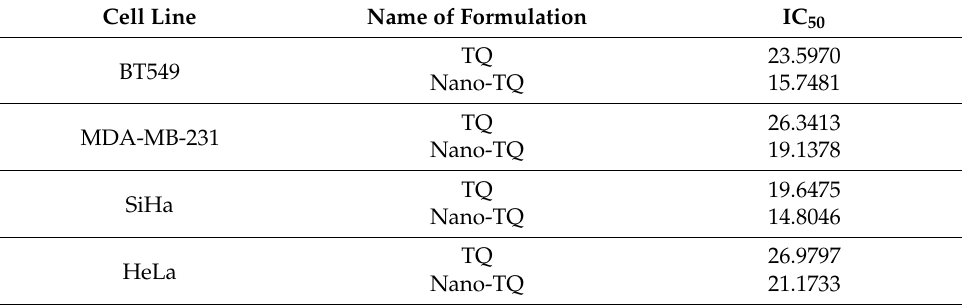
Figure 4. Effect of liposomal preparation of thymoquinone’s cytotoxic effect on cancer cell lines. Both TQ and liposomal preparation of TQ (TQ-nano) showed dose-dependent activity against BT-549 and MDA-MB-231 breast cancer cells, and SiHa and HeLa cervical cancer cells; however, in every case, the liposomal preparation of TQ increased cytotoxicity. Results are shown as mean ± SD ( n = 3). Table 2. IC 50 value of the representative liposomal formulation on different cancer cell lines. Cell